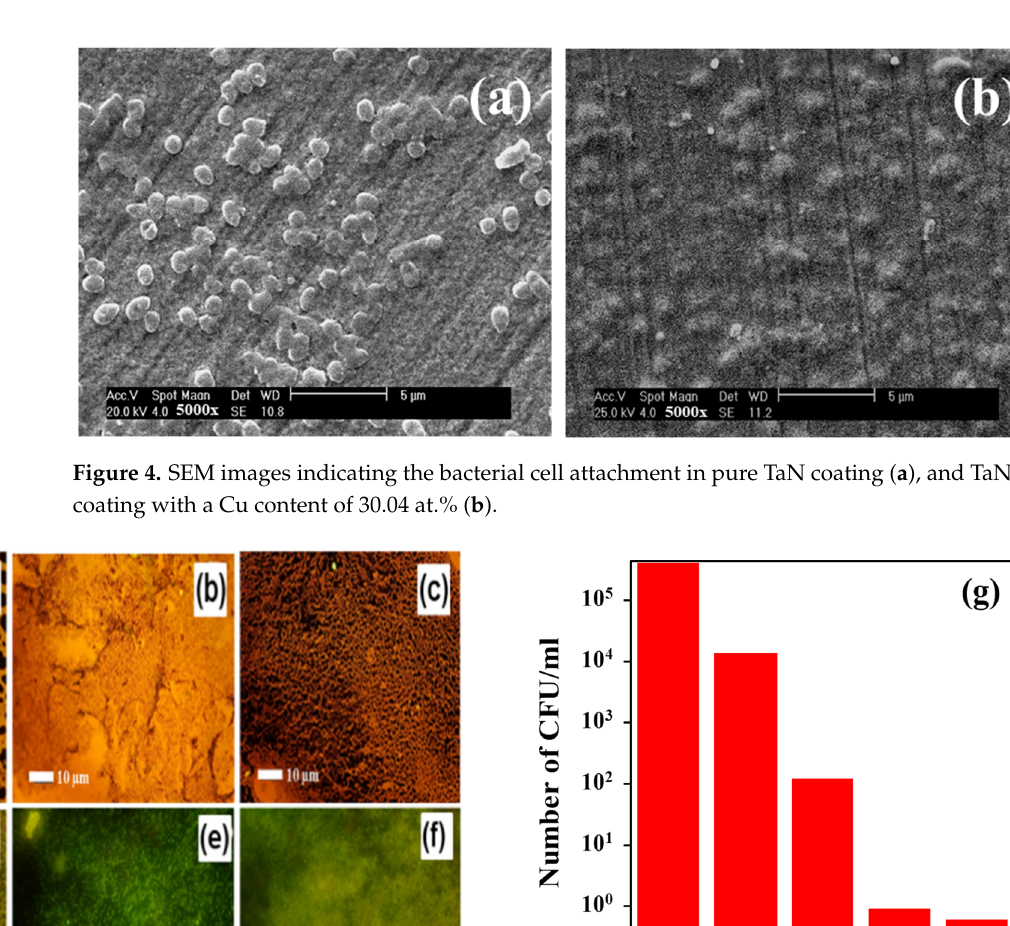
Figure 3. SEM image of TaN/Cu nanocomposite coatings with varying copper content (at.%): ( a ) 0, ( b ) 1.42, ( c ) 10.46, ( d ) 25.54, ( e ) 30.04, and ( f ) 35.